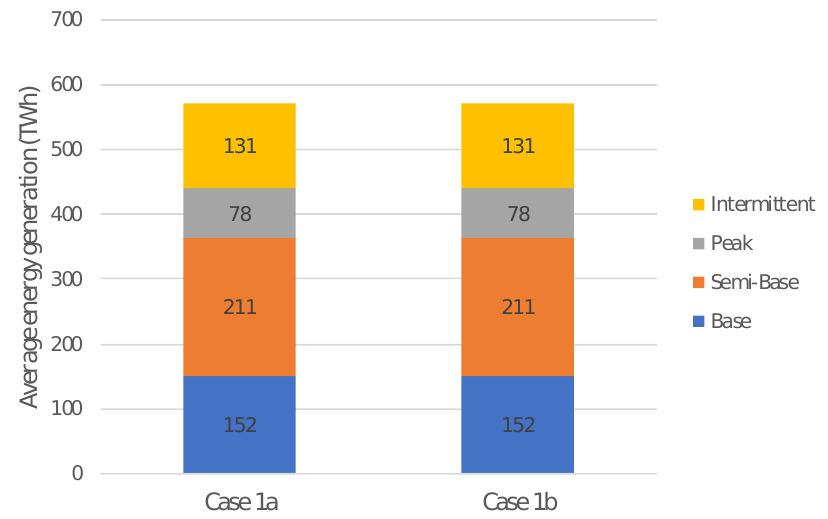
Figure 7. Average generation breakdown for Case study 1.